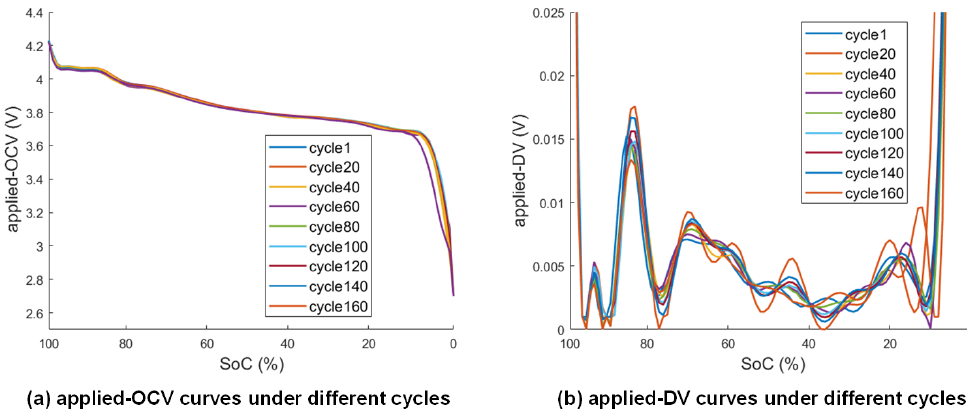
Figure 17. Applied-OCV/DV curves under different